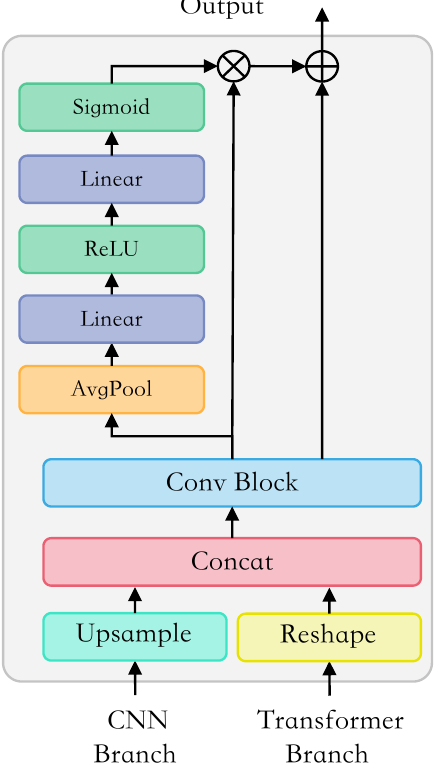
Figure 4. Structure of the proposed Spatial-spectral Feature Fusion Module.